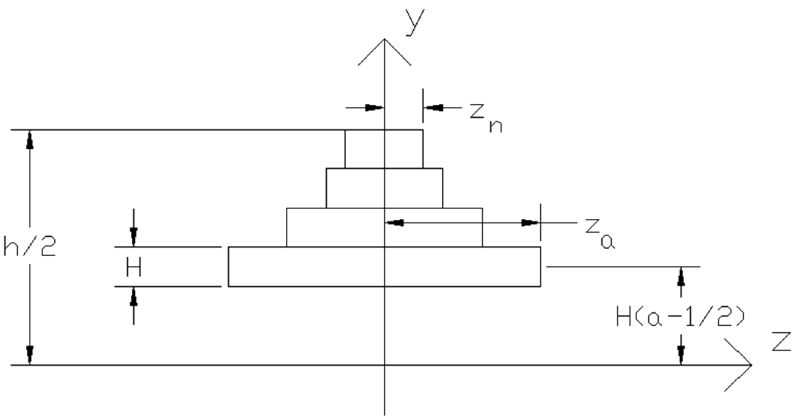
Figure 6. Calculate 𝑄 for stress at element 𝑎 .